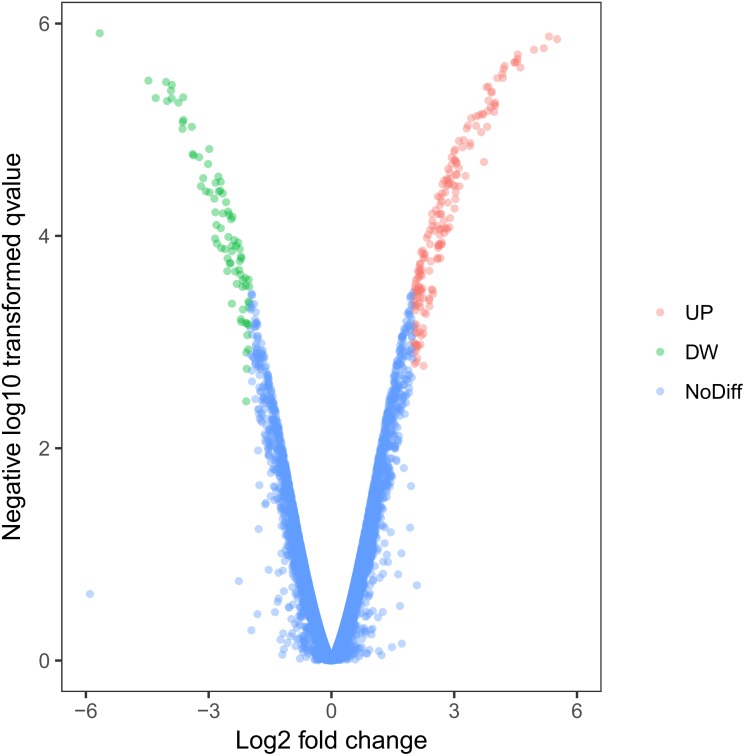
Identification of DEGs using Volcano plots.The X-axis indicates the fold change (logs value), whereas the Y-axis shows the p values (logs value). Each symbol represents a different gene, and the red/green color shows the up- or downregulated genes falling under different criteria (p value and fold change threshold). A p value <0.05 is considered as statistically significant, whereas the four fold changes were set as the threshold.